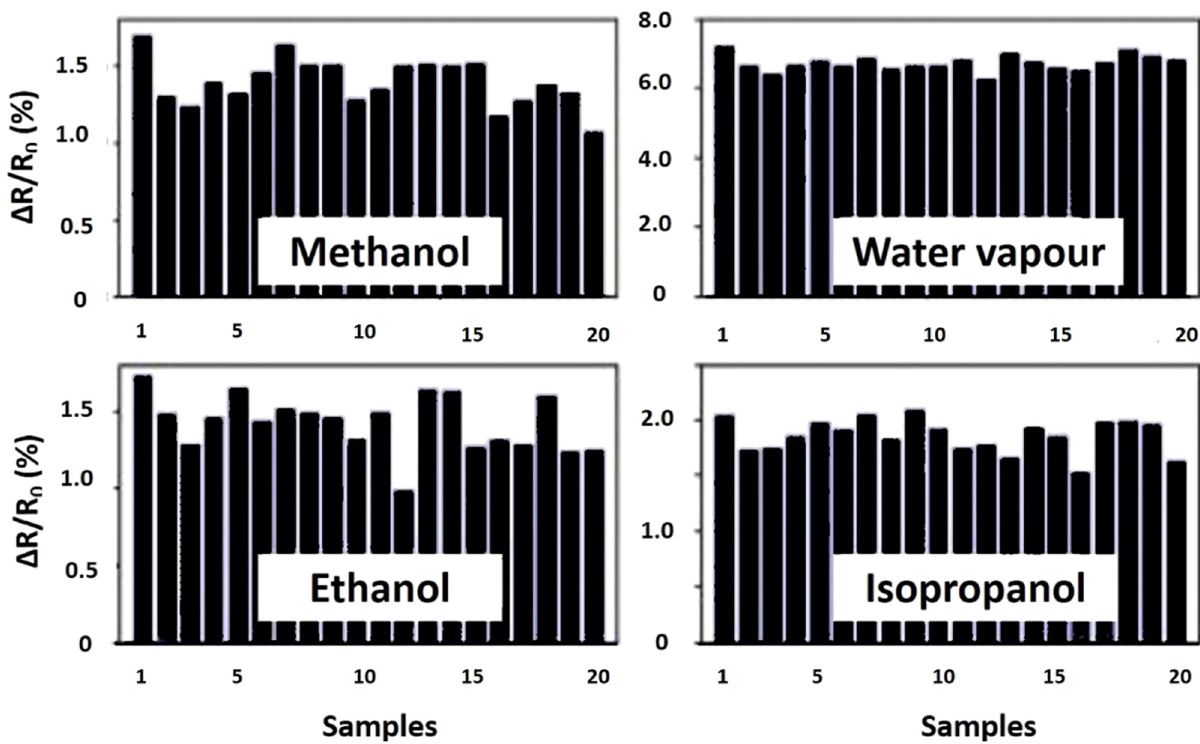
Figure 21: Scatterings of gas responses from twenty samples of rGO - based sensor to di ff erent analytes with 100% success rate at 1,000 rpm. Adapted from ref. [ 129 ]